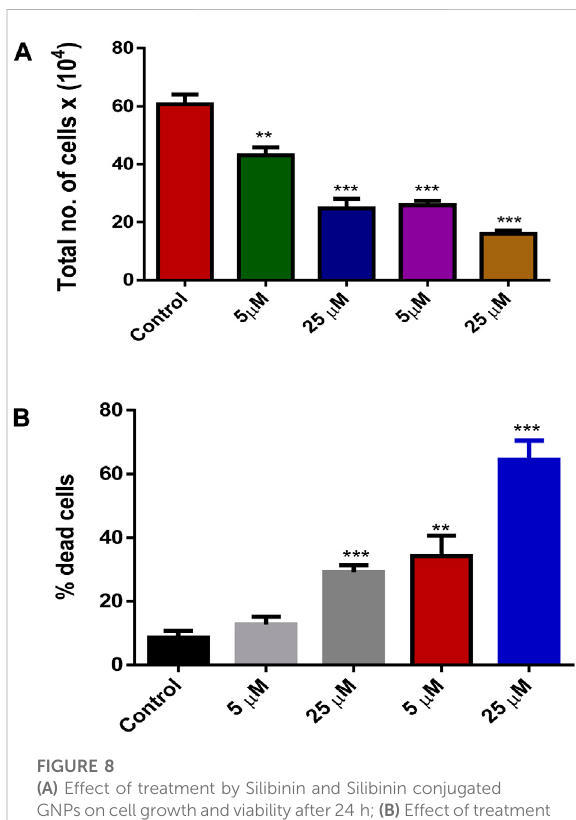
FIGURE 8 (A) Effect of treatment by Silibinin and Silibinin conjugated GNPsoncell growth andviability after24 h; (B) Effectoftreatment of silibinin and silibinin conjugated GNPs (Sb-GNPs) on cell death after 24